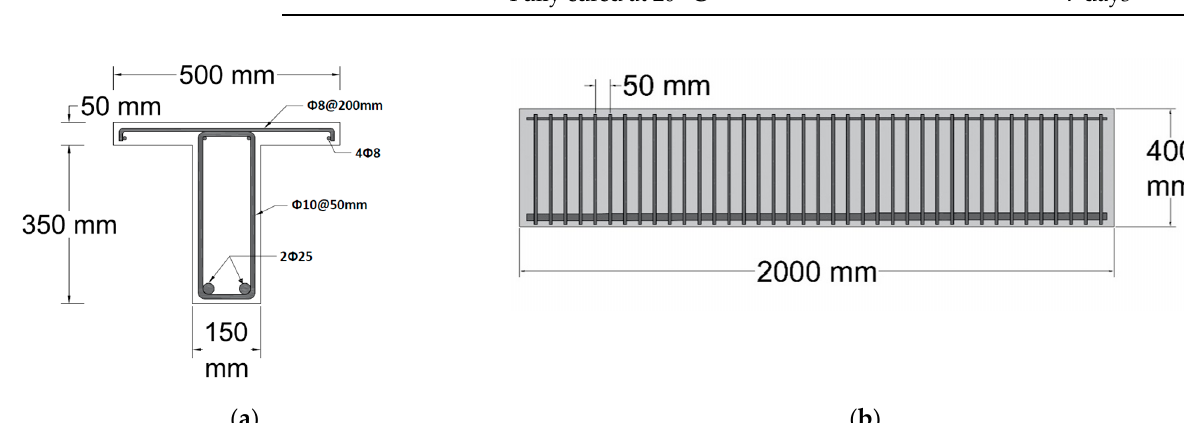
Figure 1. Section details and reinforcement; ( a ) cross-section; ( b ) longitudinal section.